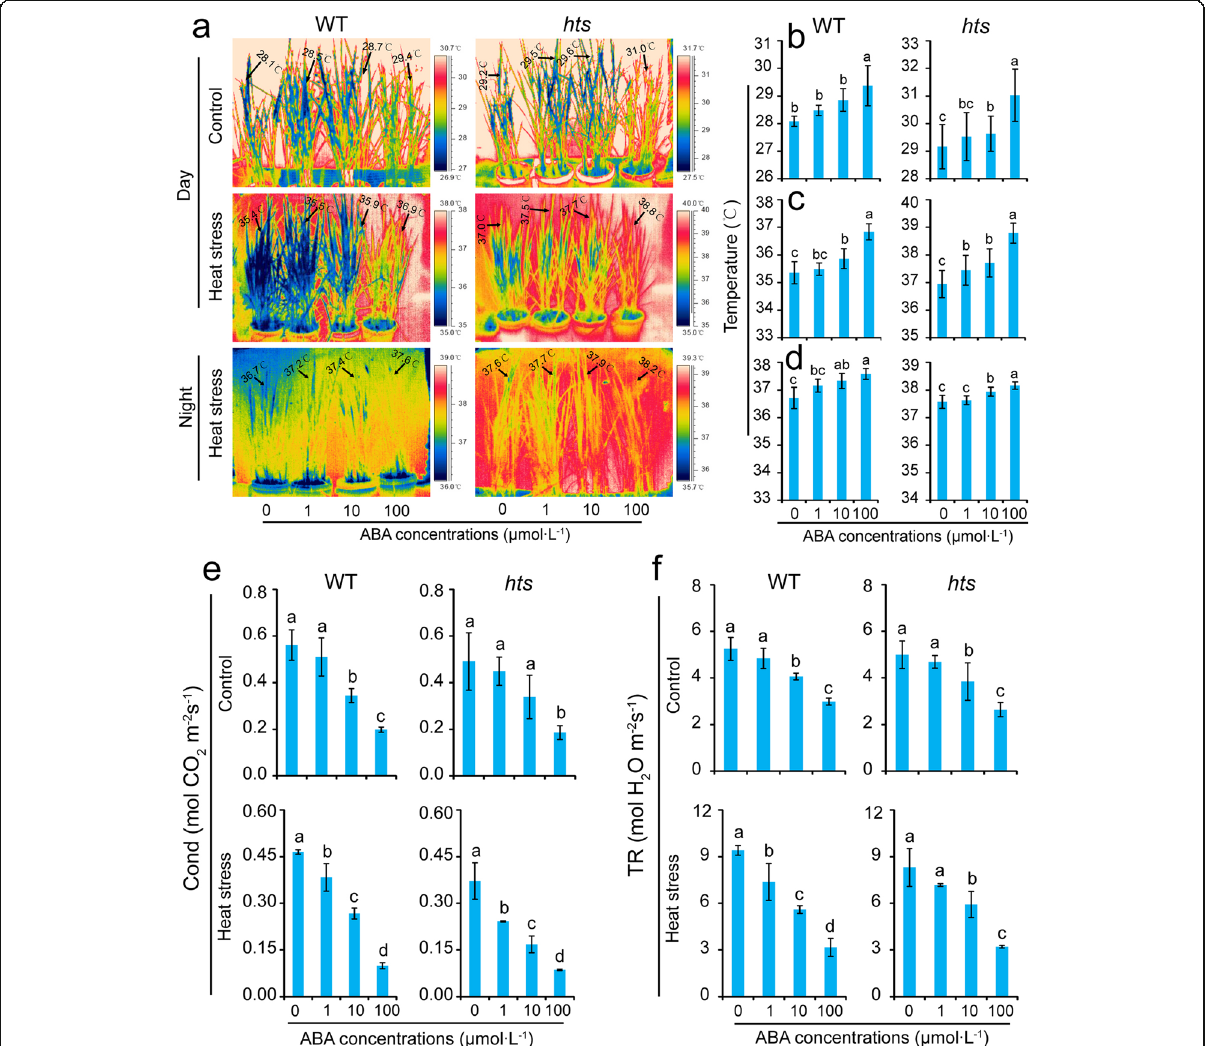
Fig. 6 Changes in tissue temperatures, stomatal conductance, and transpiration rates of rice plant leaves caused by ABA under heat stress. a , Thermal images of rice plants under the control and heat stress treatments during the day and night; b , Average leaf tissue temperature values at day under control conditions; c , Average leaf tissue temperature values at day under heat stress; d , Average leaf tissue temperature values at night under heat stress; e , Stomatal conductance (Cond); f , Transpiration rate (TR). Vertical bars denote standard deviations ( n = 10 or 3). Different letters indicate significant differences among ABA treatments under the control and heat stress conditions within a genotype by two-way analysis of variance for two factors (temperature and treatment) ( P <